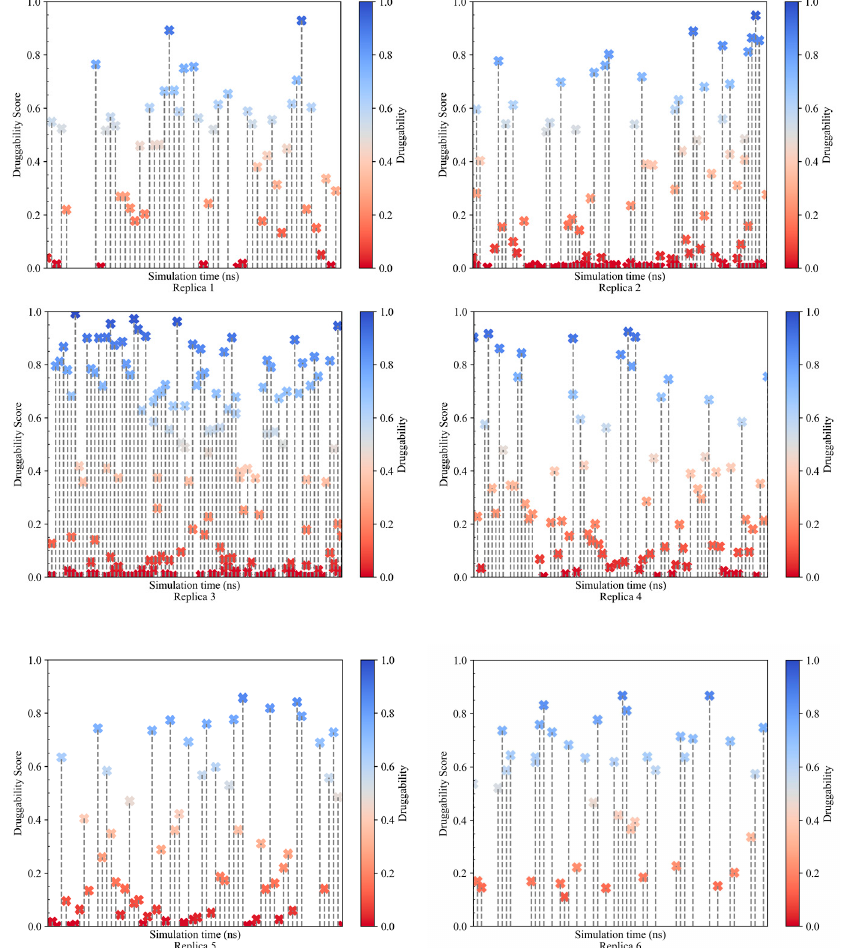
Figure 3. Druggability score of all the pockets identified in full-length NS1 over the sampled conformations obtained for six independent MD simulations.